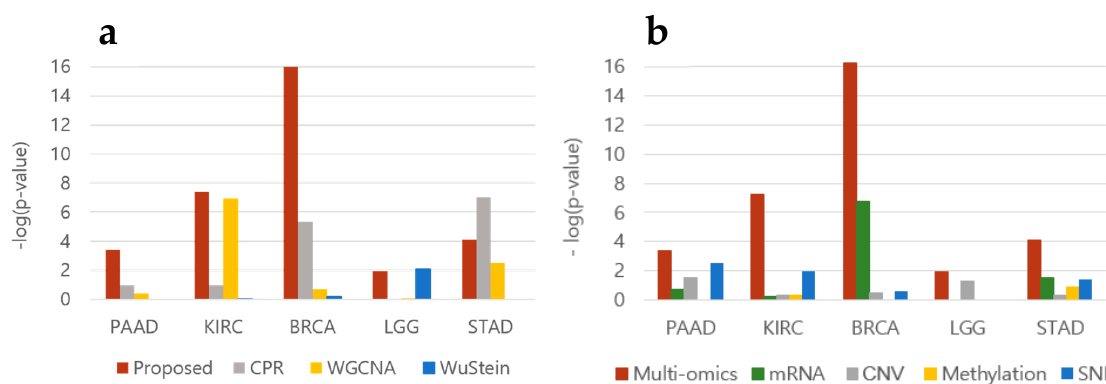
Figure 4. Significance of the oncogenes inclusion ratio for each ( a ) method and ( b ) omics dataset. Significance values of the oncogenes identified from intOGene were calculated using hypergeometric tests. Complete contingency tables are provided in Supplementary Table S4.